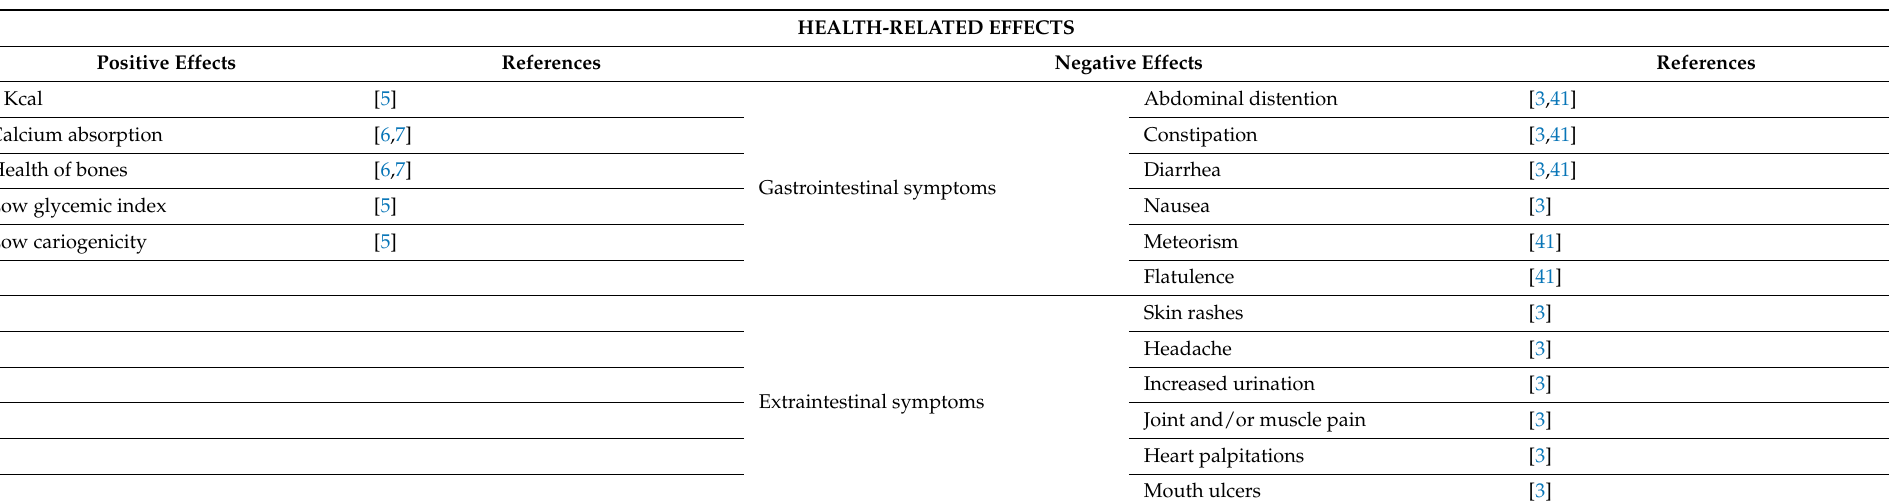
Table 2. Main positive and negative effects of lactose on human